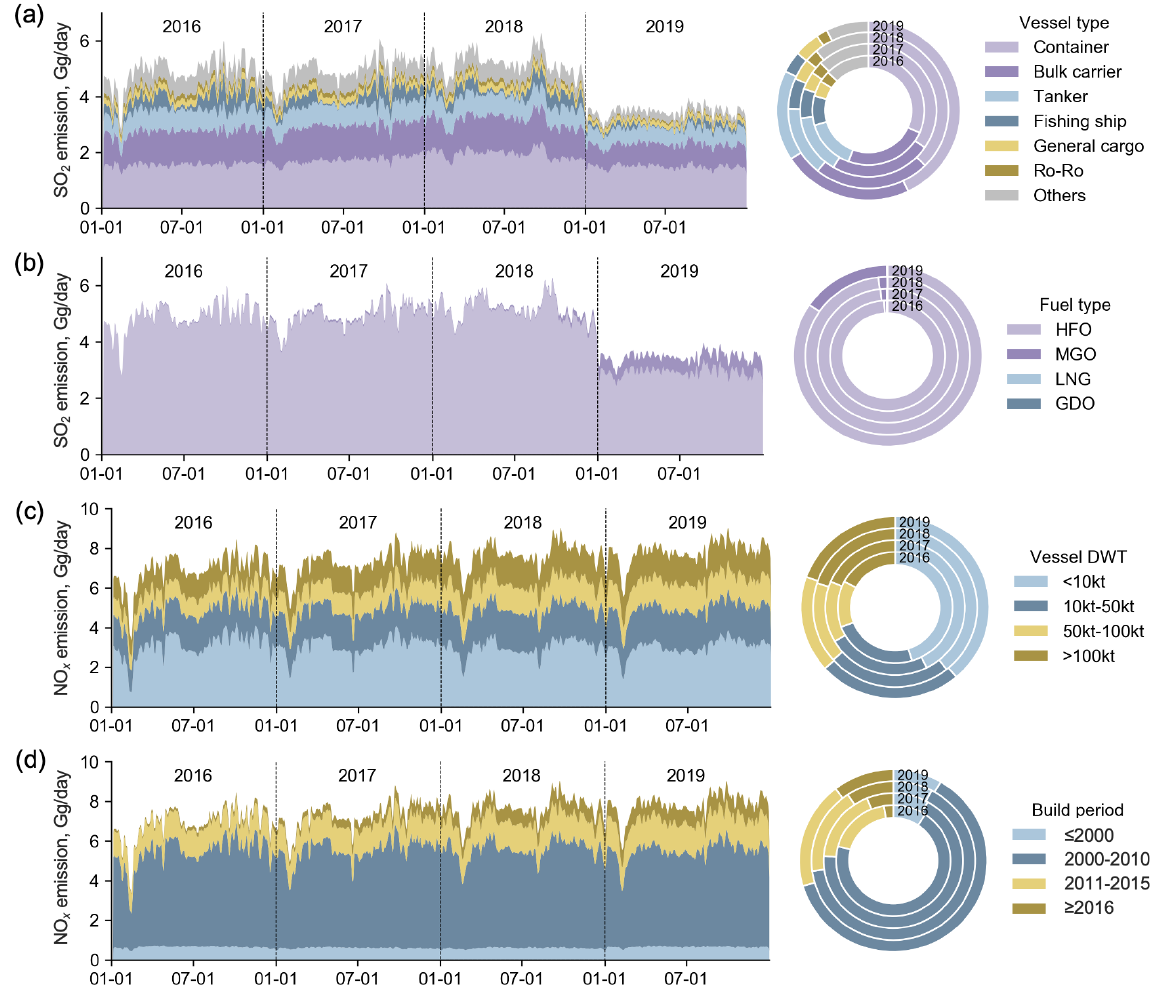
Figure 8. The 5d moving average of SO 2 and NO x emissions from ships around China from 2016 to 2019. Ship SO 2 emission composition by (a) vessel type and (b) fuel type and ship NO x emission composition by (c) vessel build period and (d) dead weight tonnage